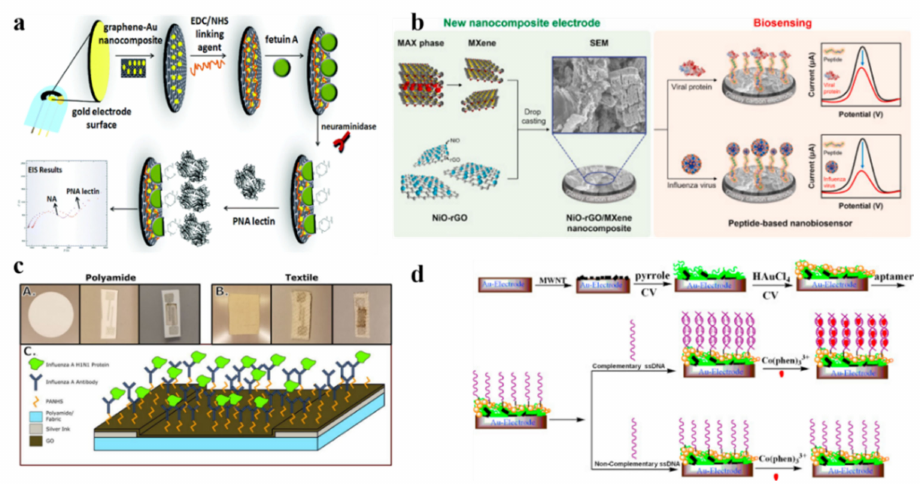
Figure 1. Schematic diagram depicting fabrication of electrochemical biosensors with carbon nano- materials for detecting influenza: ( a ) biosensor fabricated with graphene for detecting influenza A [71]; ( b ) biosensor fabricated with a nickel oxide-reduced graphene oxide (NiO-rGO)/MXene nanocomposite for detecting influenza virus and viral protein [70]; ( c ) biosensor fabricated with graphene oxide layer supported by both nanoporous polyamide and consumer utility textiles for detecting environmental exposure to influenza A virus [39]; ( d ) biosensor fabricated with multi-wall carbon nanotubes for detection of H5N1 gene sequence of avian influenza virus [37]. ( a ) Reproduced with permission Copyright 2017, Royal Society of Chemistry. ( b , d ) Reproduced with